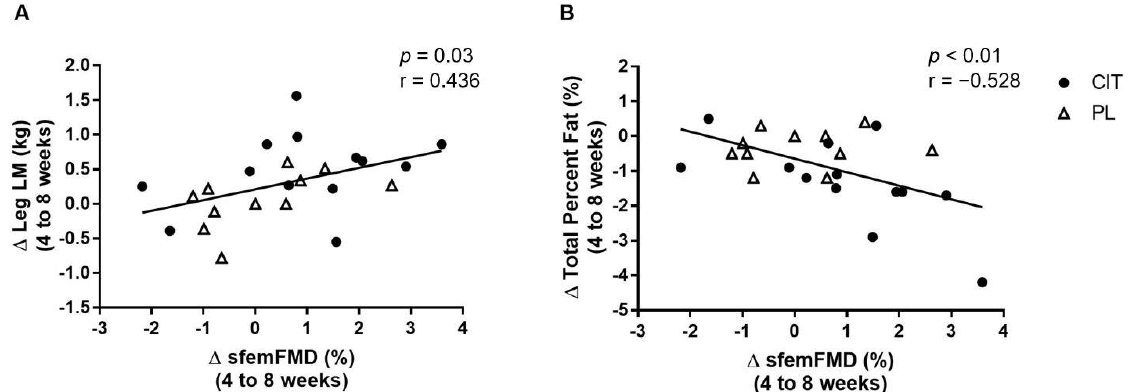
Figure 7. Correlations between changes ( ∆ ) in superficial femoral artery flow-mediated dilation (sfemFMD) and leg lean mass (LM) ( A ) and total percent fat ( B ) from 4 weeks to 8 weeks.